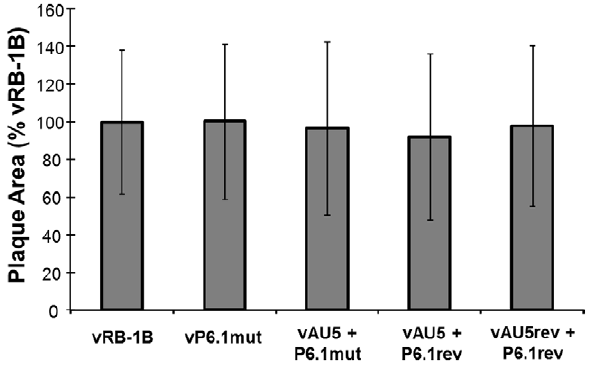
Figure 5. Invitro replication of parental, mutant, and revertant viruses. Plaque areas were determined for 100 randomly selected plaques for the indicated viruses. Results are shown as mean plaque areas in percent of the parental vRB-1B with standard deviations (error bars).